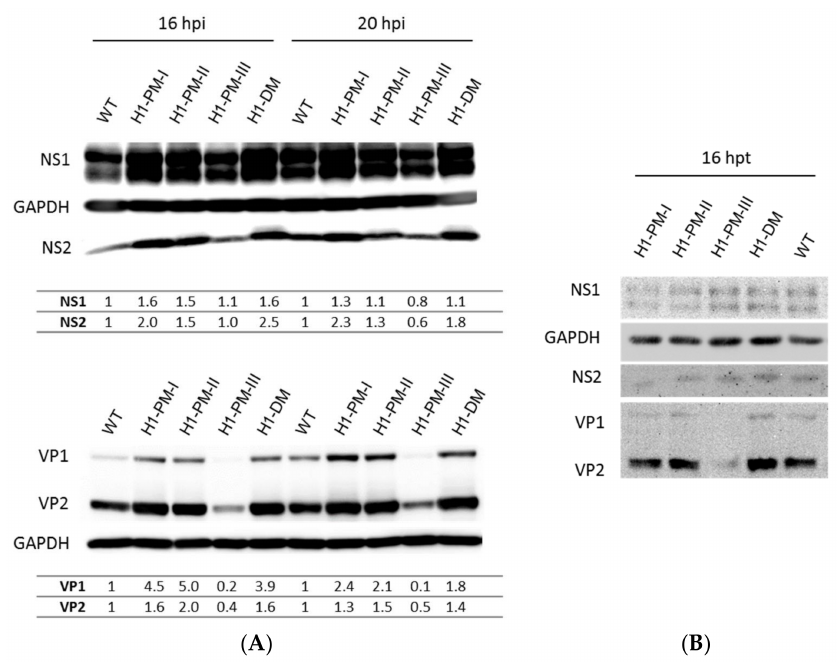
Figure 5. Accumulation of viral proteins expressed from wt H-1PV or the mutants in NB-324k cells. ( A ) Accumulation of viral proteins after infection of NB-324k cells. NB-324K cells (5 × 10 5 ) were infected with wt H-1PV, H1-PM-I, H1-PM-II, H1-PM-III, or H1-DM (MOI, 2225 Vg/cell) and further incubated in the presence of neutralizing antibodies. Protein extracts were prepared 16 h and 20 h post-infection and subjected to a 10% SDS-PAGE gel electrophoresis, followed by immunoblotting using rabbit polyclonal antisera recognizing NS1 and NS2 or VP proteins. Signal intensities of the viral proteins were quantified by Lab-1D software and normalized relative to the density of the corresponding wt NS and VP proteins; ( B ) Accumulation of NS1/NS2 and VP proteins expressed from pH1 or mutant-derived plasmids after transfection. NB-324K cells (5 × 10 5 ) were transfected with 6 µ g of pH1, pH1-PM-I, pH1-PM-II, pH1-PM-III, or pH1-DM protein extracts prepared 16 h post-transfection and processed as for ( A